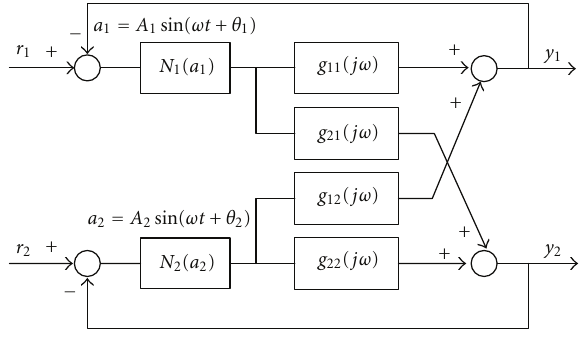
Figure 2: Block diagram of a 2 × 2 nonlinear multivariable feedback control